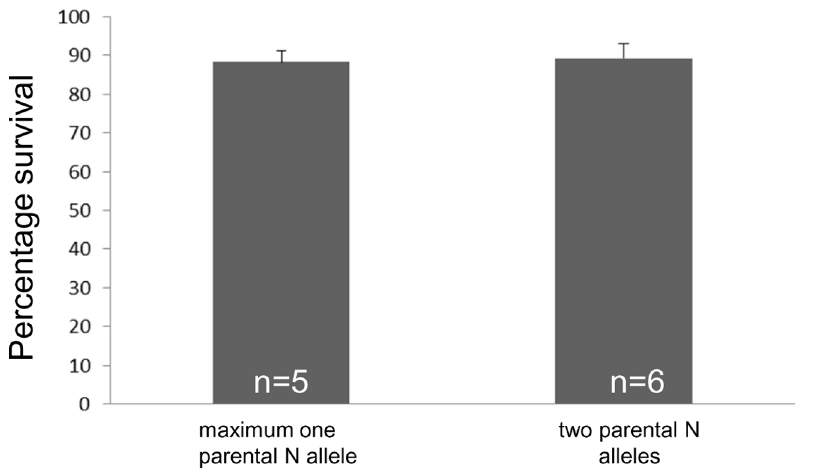
Figure 2. The survival rates from crosses with two nude/linear parents and those with only one were not different. All brooders were of European origin. Survival percentage was measured on seventh day post hatching and calculated as live fry number/total egg number. Three to five technical replicates per sample were counted. The difference between the two groups is not statistically significant (Student’s t-test; P=0.63).